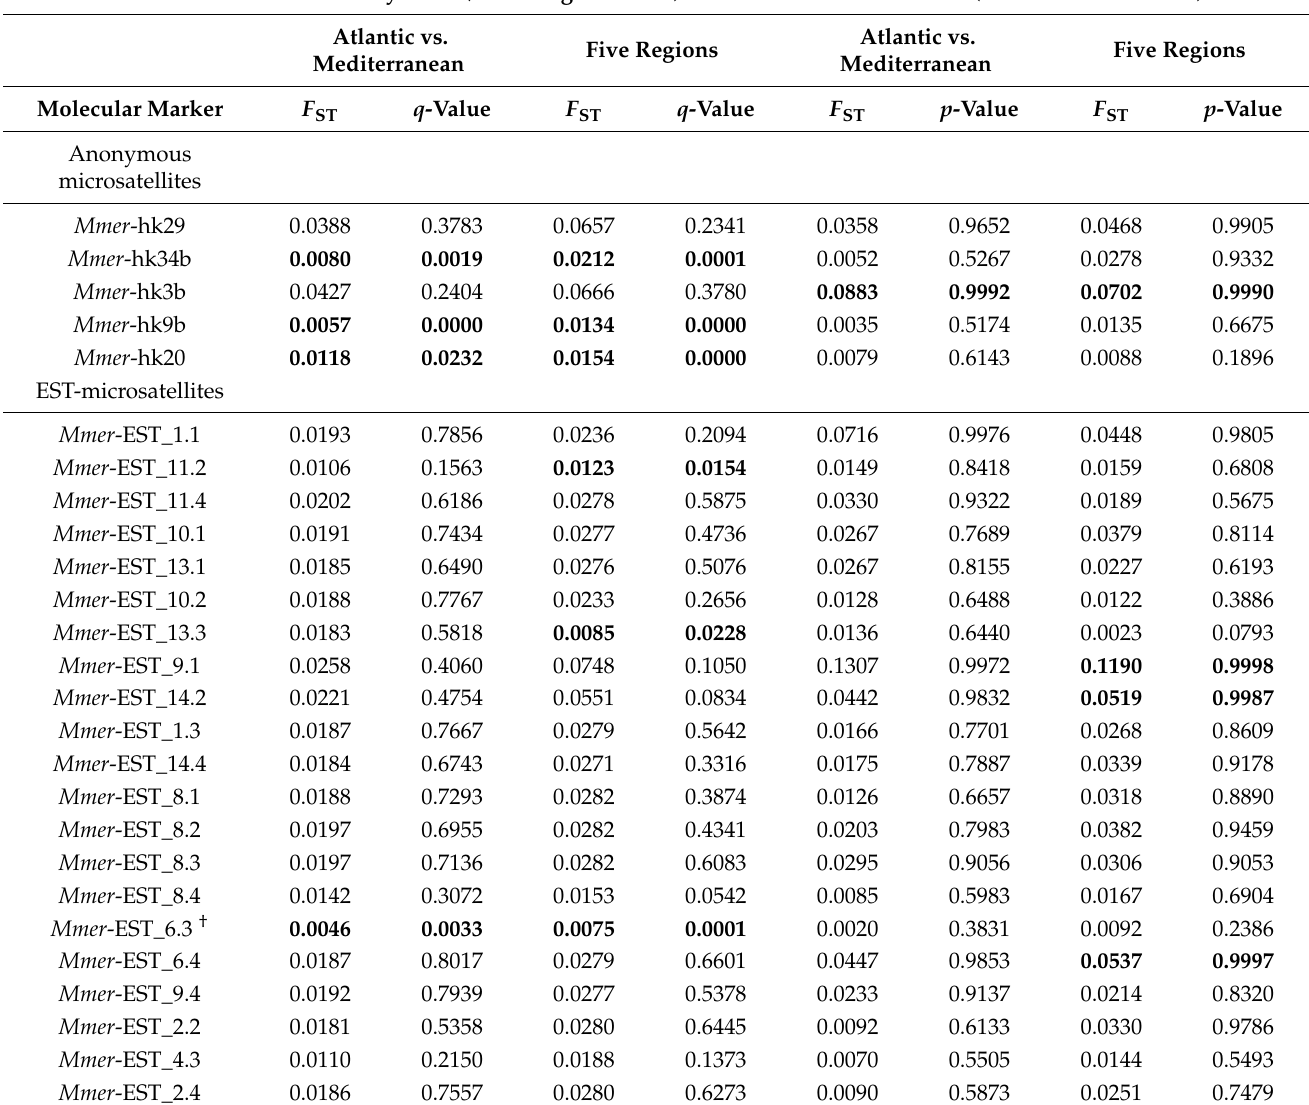
Table 1. Selection tests from BAYESCAN and LOSITAN on two hierarchical levels: between two subpopulations and among five regions (see Figure 1). Significant q -values after FDR correction are bolded and suggest balancing selection. The q -value is the statistical probability that an F ST was significantly different from zero (see [54]). Significant p -values after the FDR correction ( p ≥ 0.9987) are bolded and suggest directional selection, i.e., the probability that a marker violates the evolutionary neutral model (0.05 < neutral evolution < 0.95, before the FDR correction). BayeScan (Balancing Selection) Lositan (Directional Selection) Atlantic vs. Atlantic vs. Five Regions Mediterranean